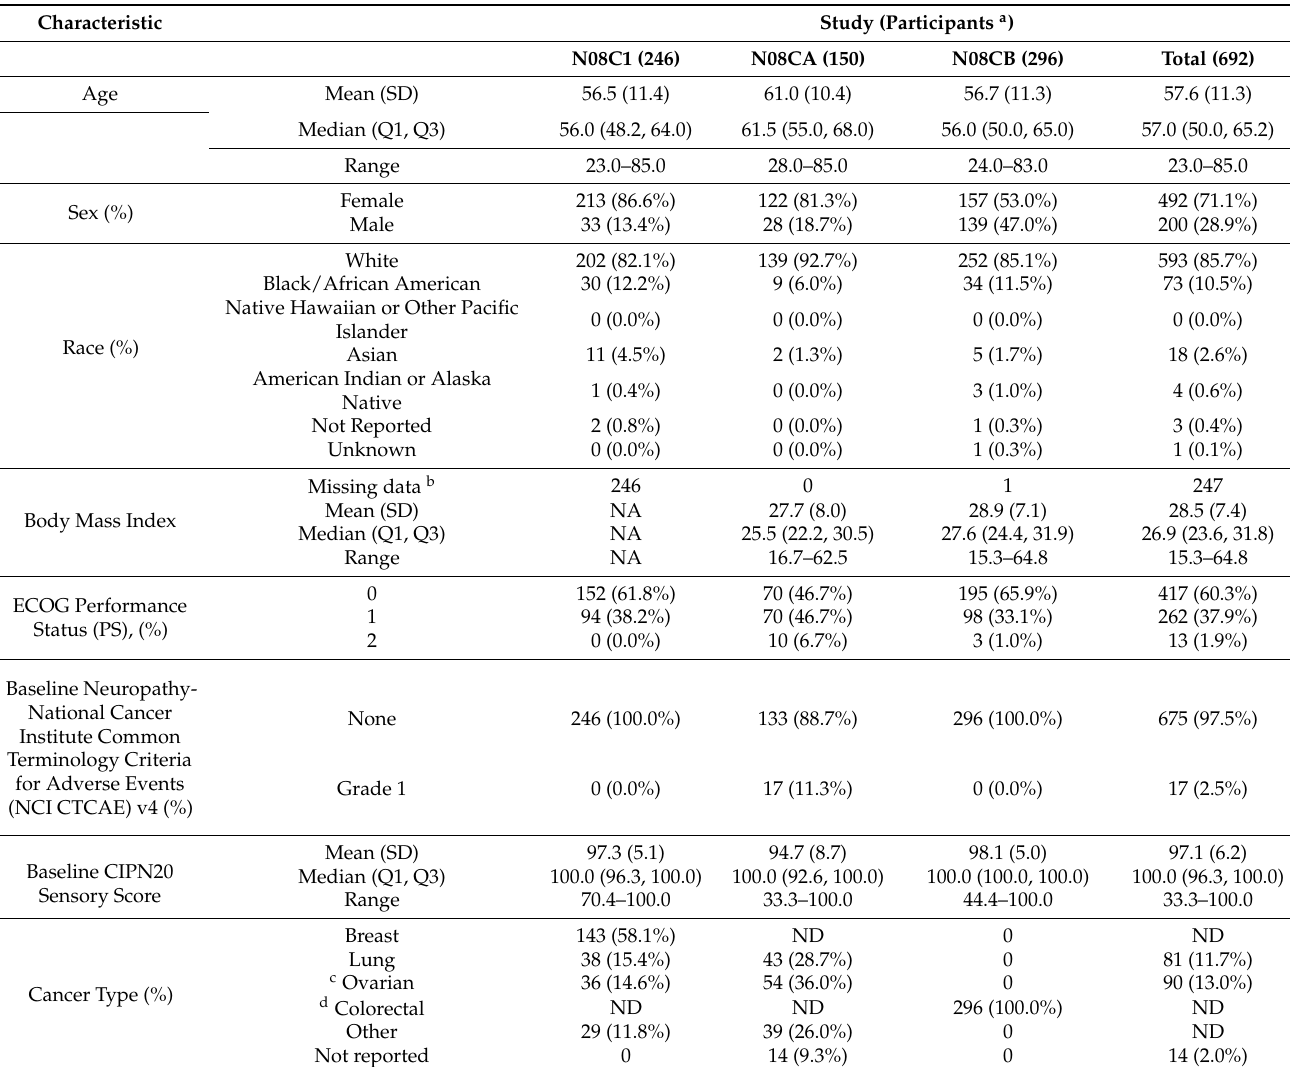
Table 1. Baseline characteristics of the N08Cx study